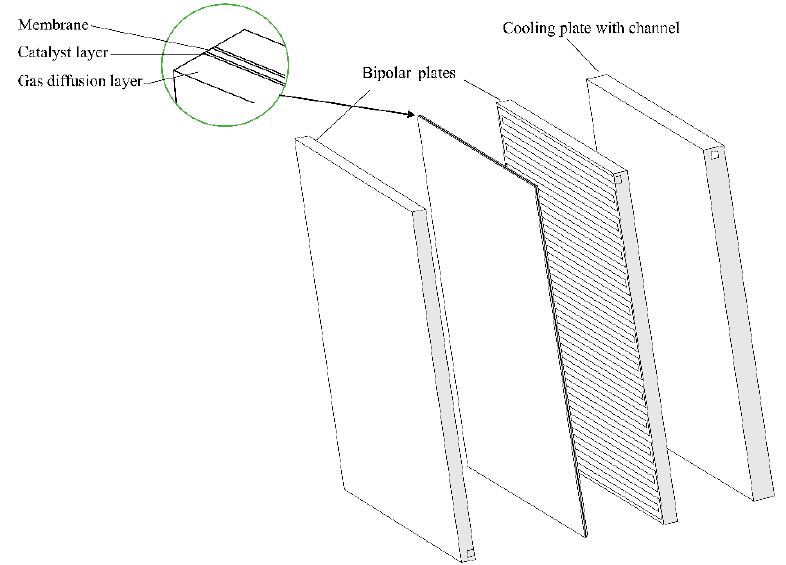
Figure 1. Single cell structure of PEMFC.